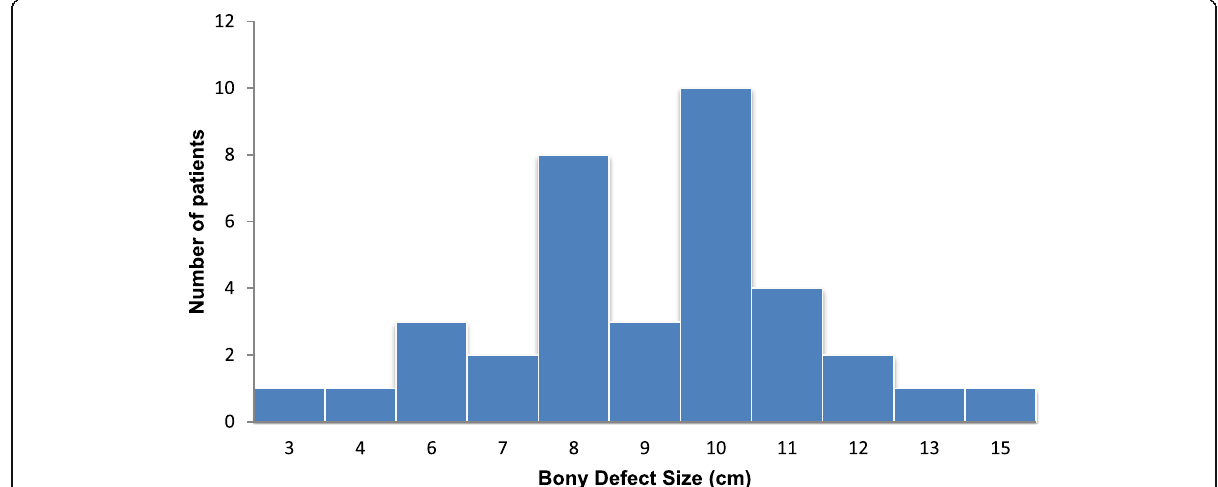
Fig. 1 Histogram showcasing the distribution of bony defects by size for the entire patient cohort